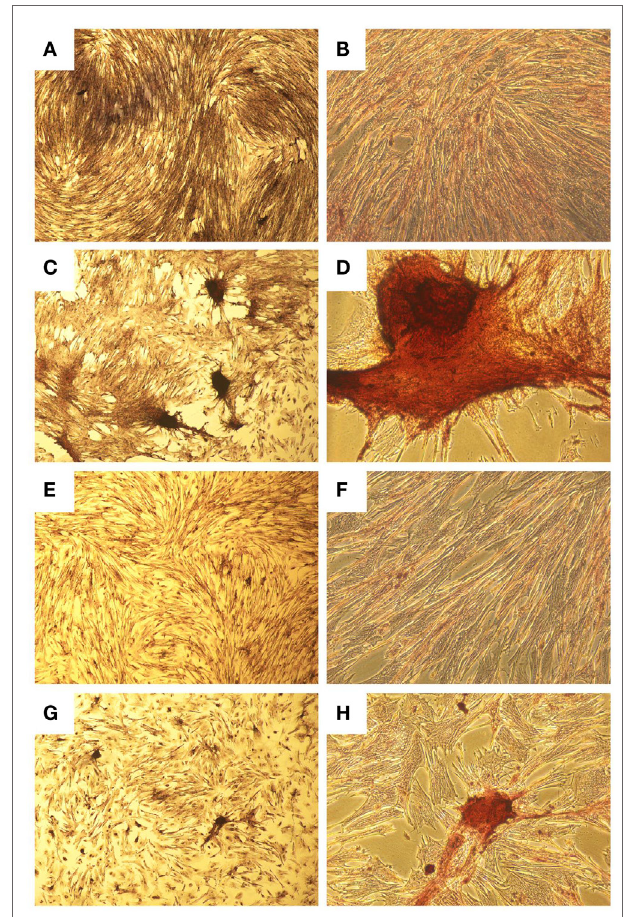
FigUre 3 | histological images showing osteogenic differentiation of cells. Adipose tissue (a–D) or bone marrow (e–h) stained with Alizarin Red for calcium at two magnifications. Control aMSCs [ (a) 4 × ; (B) 20 × ] or differentiated aMSCs in osteogenic medium [ (c) 4 × ; (D) 20 × ]. Control bMSCs [ (e) 4 × ; (F) 20 × ] or differentiated bMSCs in osteogenic medium [ (g) 4 × ; (h) 20 × ].